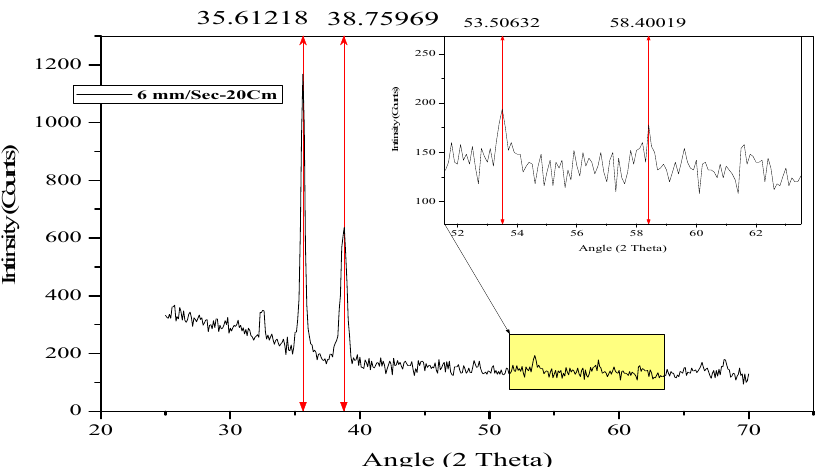
Fig. 1b: XRD pattren of CuO layer prepared at 6